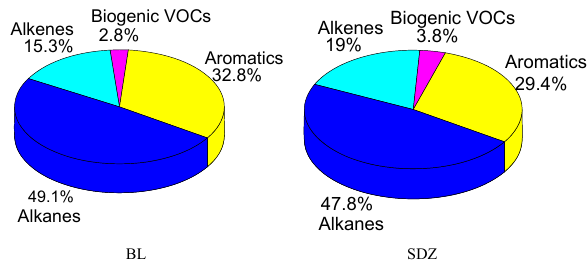
Fig.4 Percentages of alkanes, alkenes, biogenic VOCs and aromatics in NMHCs at BL (left, 2 Fig. 4. Percentages of alkanes, alkenes, biogenic VOCs and aro- matics in NMHCs at BL (left, TNMHCs: 149 ppbv) and SDZ (right, TNMHCs: